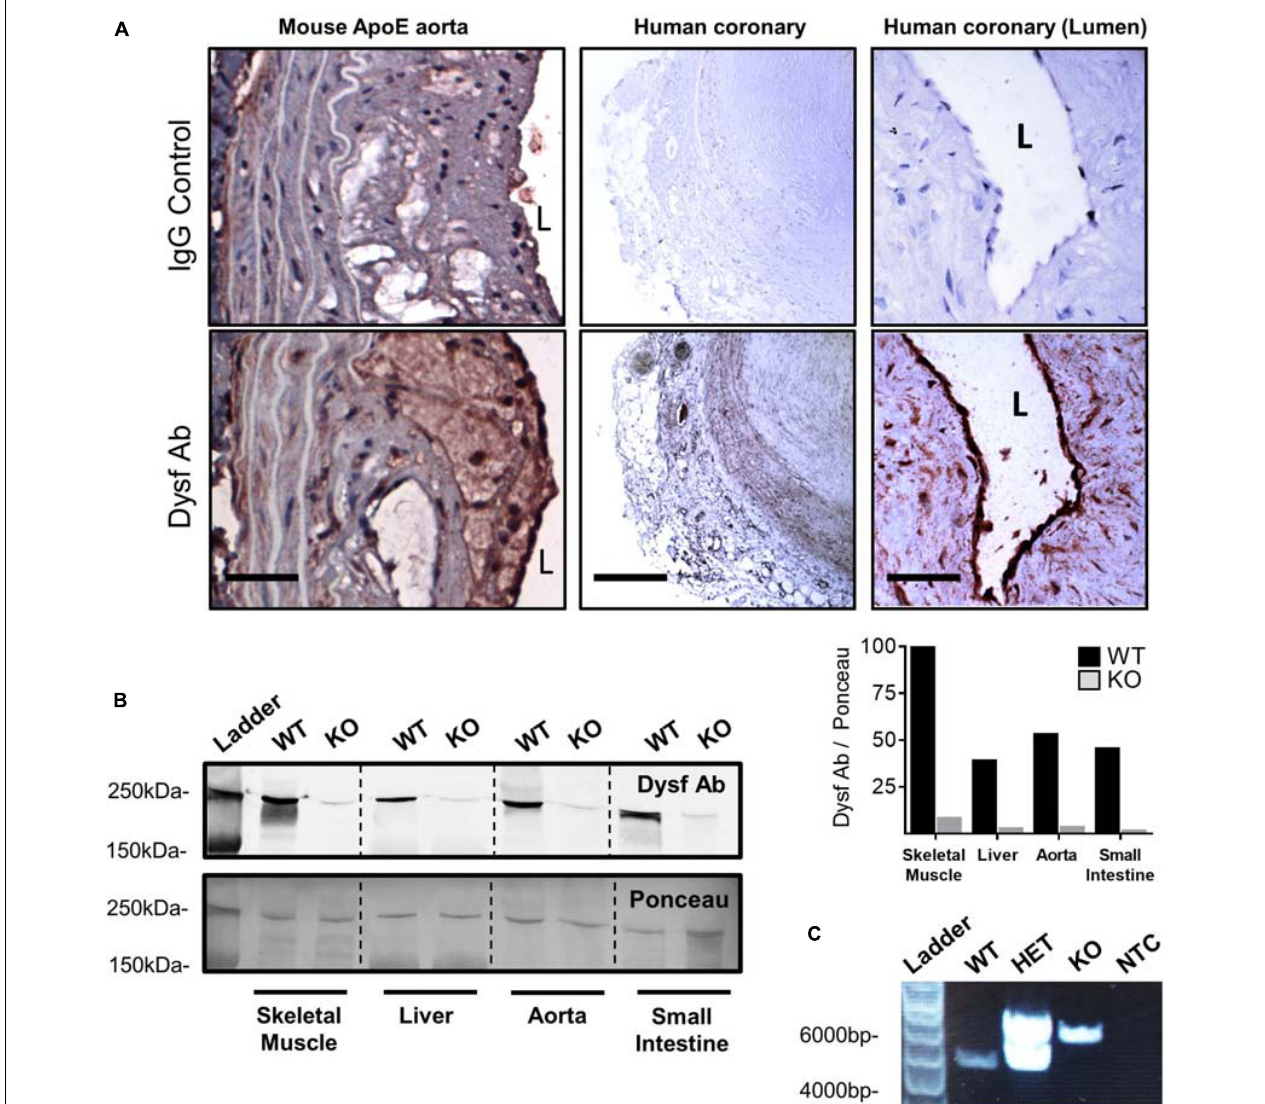
FIGURE 1 | High dysferlin expression in mouse and human atherosclerotic lesions. (A) Dysferlin Ab and control detection in representative ApoE-null mouse aortic sections (scale bar = 40 µ m) and human coronary lesions (scale bar = 600 µ m and scale bar = 50 µ m) using goat anti-dysferlin antibodies or IgG with hematoxylin counterstain. (B) Tissue specific detection and knockout efficiency of Dysferlin in mouse lysates (skeletal muscle, liver, thoracic aorta, and small intestine) via western blot using the mouse anti-dysferlin; NCL-Hamlet 1 antibody in wild type (WT) and Dysf (KO) mice. Quantification of Dysf Ab is shown relative to ponceau staining, and expressed as a percentage of the WT:skeletal muscle signal. (C) Genotyping PCR using ear clip DNA biopsies of wild type (WT), heterozygous mutant (HET), and homozygous mutant Dysf (KO) mice, as well as a no template control